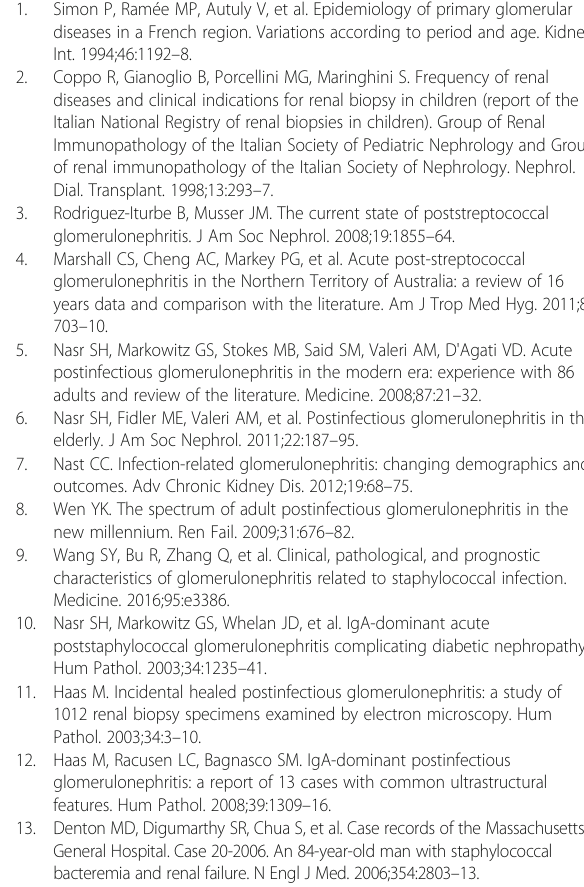
Additional file 1: Figure 1 : C4d immunohistochemistry. Additional file 2: Table 1 : Treatments. Additional file 3: Table 2: Follow-up and renal